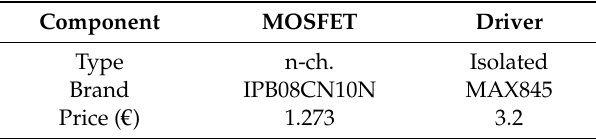
Table 2. MOSFET and driver taken into account.